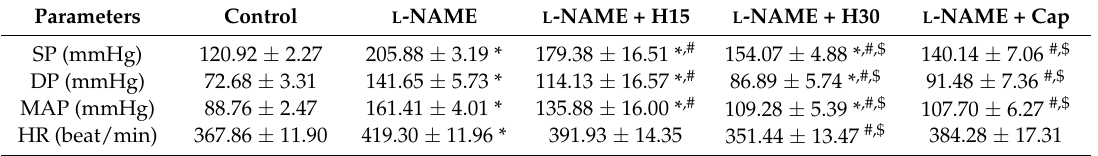
Table 1. Effects of hesperidin and captopril on blood pressure and heart rate in anesthetized rats. Parameters